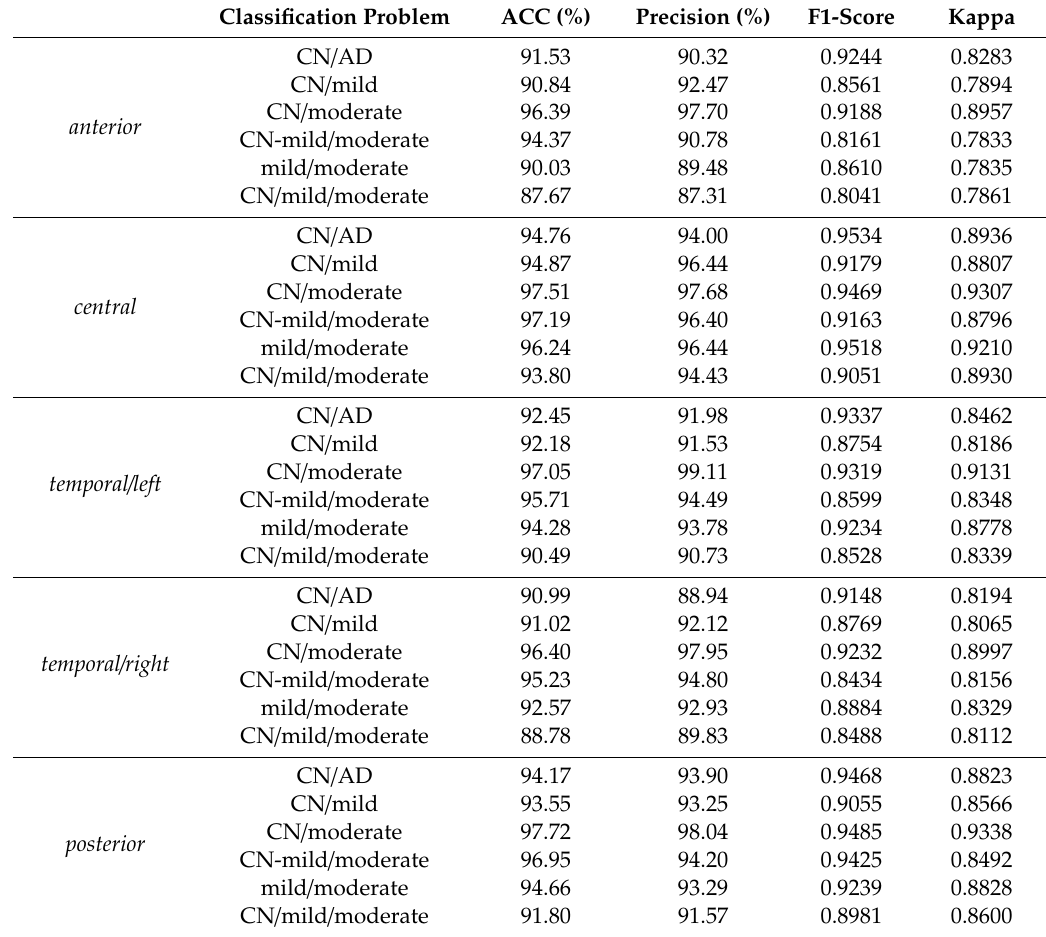
Table 5. The classification results in terms of the Accuracy (ACC), Precision, F1-score, and Kappa statistics for the anterior (Fp1, F3, Fz, Fp2, and F4), central (C3, Cz, and C4), left / temporal (F7, T3, and T5), right / temporal (F8, T4, and T6), and posterior (O1, O2, P3, Pz, and P4) clusters. For the analysis, the electroencephalographic (EEG) signals were segmented in epochs of 12 nonoverlapping